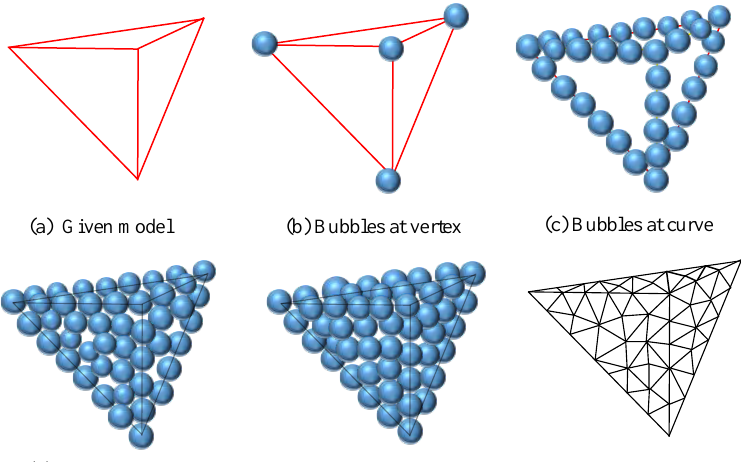
Figure 2. Bubble meshing